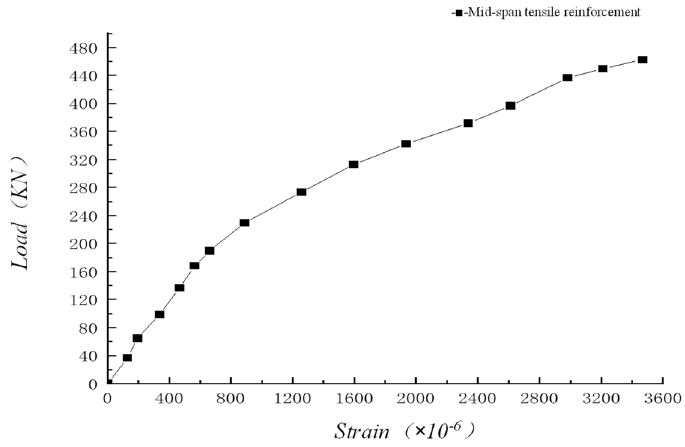
Figure 33. Stretch − load curve of mid − span tensile steel.